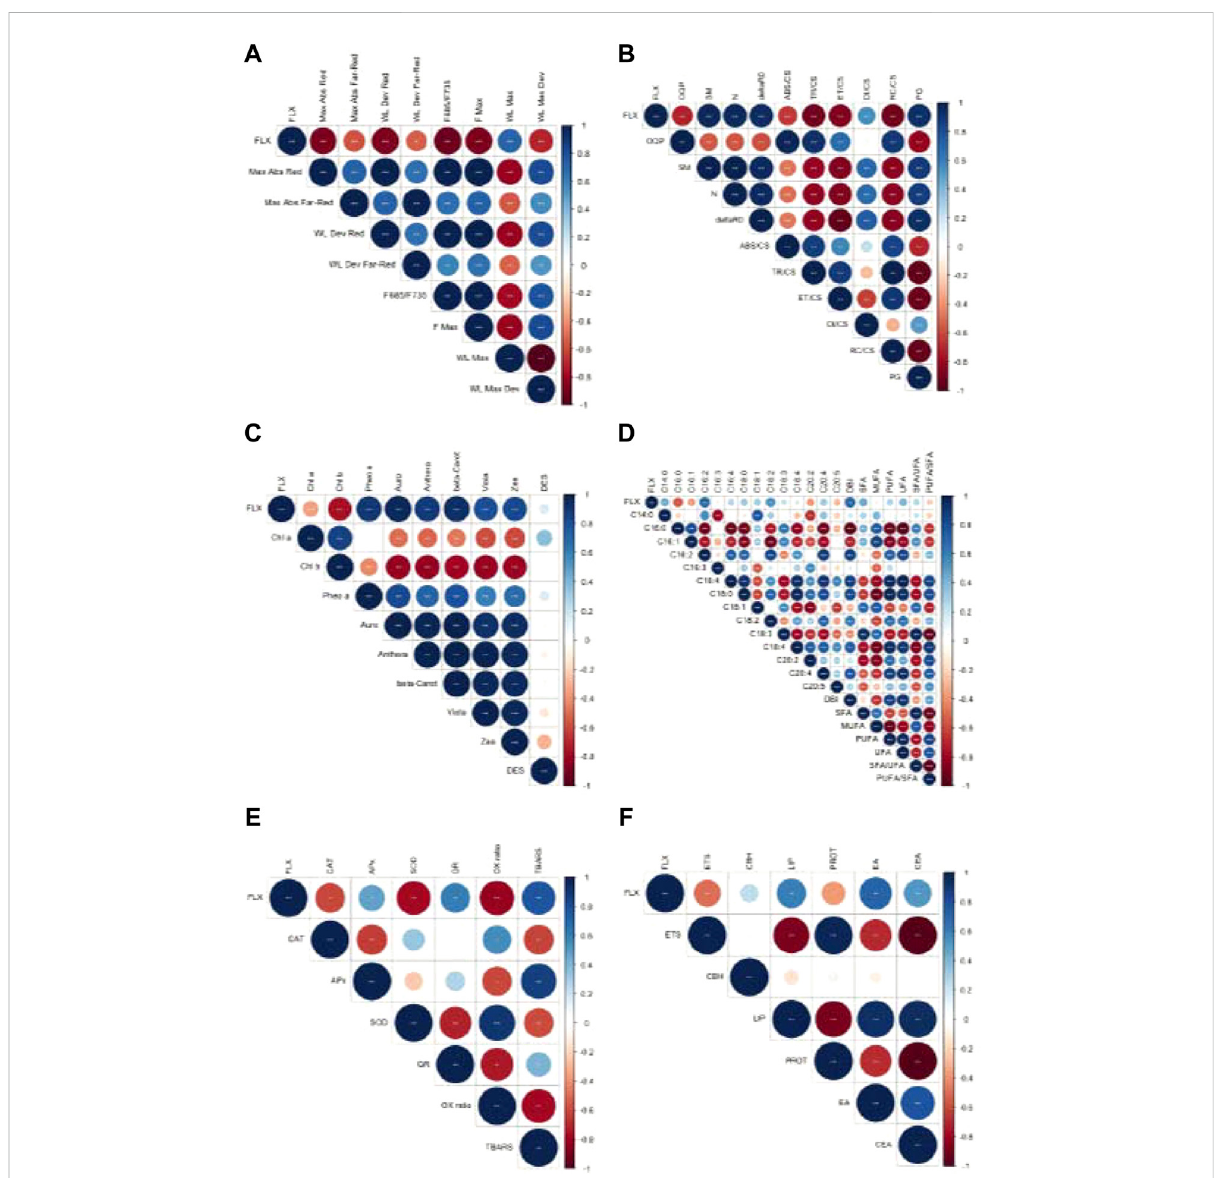
FIGURE 6 Ulva lactuca Spearman correlations with fl uoxetine exposure. (A) LIF-derived variables. (B) PAM-derived variables. (C) Pigment concentration variables. (D) Fatty acid analysis variables. (E) Oxidative stress variables. (F) Energy metabolism variables. Shades of blue indicate positive correlations while shades of red indicate negative correlations between parameters. N = 30 ( fl uorometric data); N = 3 (pigments, oxidative stress and energetic biomarkers and fatty acids); asterisks indicate statistically signi fi cant differences at p < 0.05 (*), 0.01 (**) and 0.001